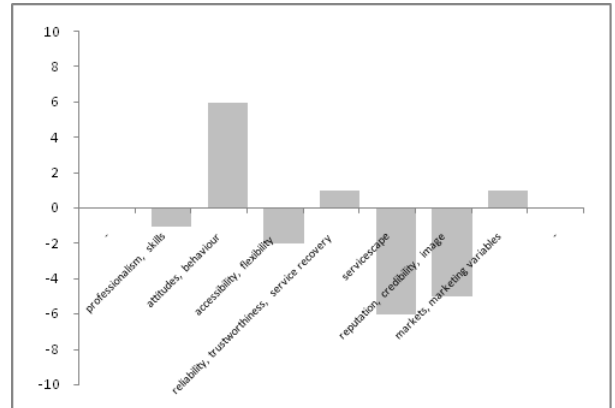
Figure 8: The underlying drivers of consumption in Factor 5 Factor 6: Good employees, poor systems